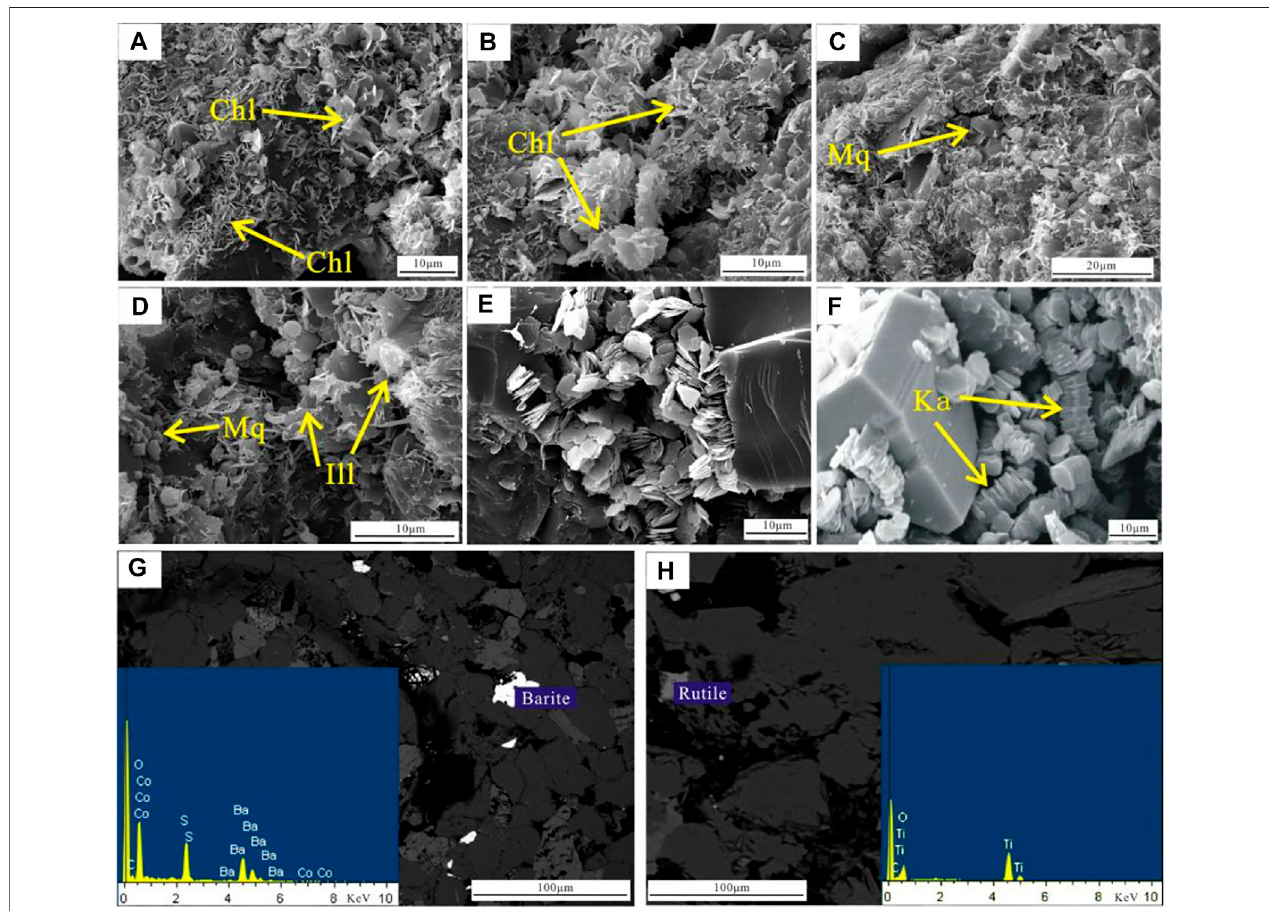
FIGURE7| Images of SEM and EMPA of authigenic clay minerals and hydrothermal minerals in the Huangliu sandstones. (A) Well AF-2 – 1, 3,042.12 m, needle-shaped and foliated chlorite present on particle surface. (B) Well AF-2 – 8, 3,082.65 m, needle-shaped chlorite wrap the surface of particle. (C) Well AF-1 – 12, 2,712.75 m, fi lamentous and foliaceous illite cover feldspar grain and microquartz (Mq) are encircled by illite and chlorite aggregate. (D) Well AF- 1 – 12, 2,706.58 m, foliaceous and threadlike illite fi ll intergranular pores, and microquartz grains are surrounded by authigenic illite and chlorite. (E) Well AF-1 – 6, 2,861.32 m, abundant plate shape authigenic kaolinite fi ll interparticle space. (F) Well AF-1 – 4, 2,867.44 m, vermiform authigenic kaolinite exist in dissolved pore. (G) Well AF-1 – 6, 2,861.54 m, authigenic hydrothermal mineral of barite is detected. (H) Well AF-1 – 12, 2,709.71 m, hydrothermal mineral of rutile is